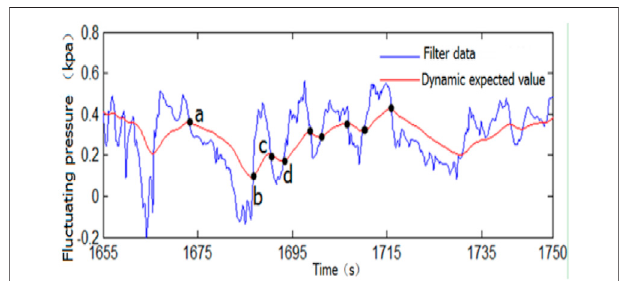
FIGURE 11 | Piles layout and locating pieces on the main test pile. (A) Schematic diagram of the wharf structure. (B) The pile arrangement plan units: mm. (C) Locating pieces of the main test pile units: m.